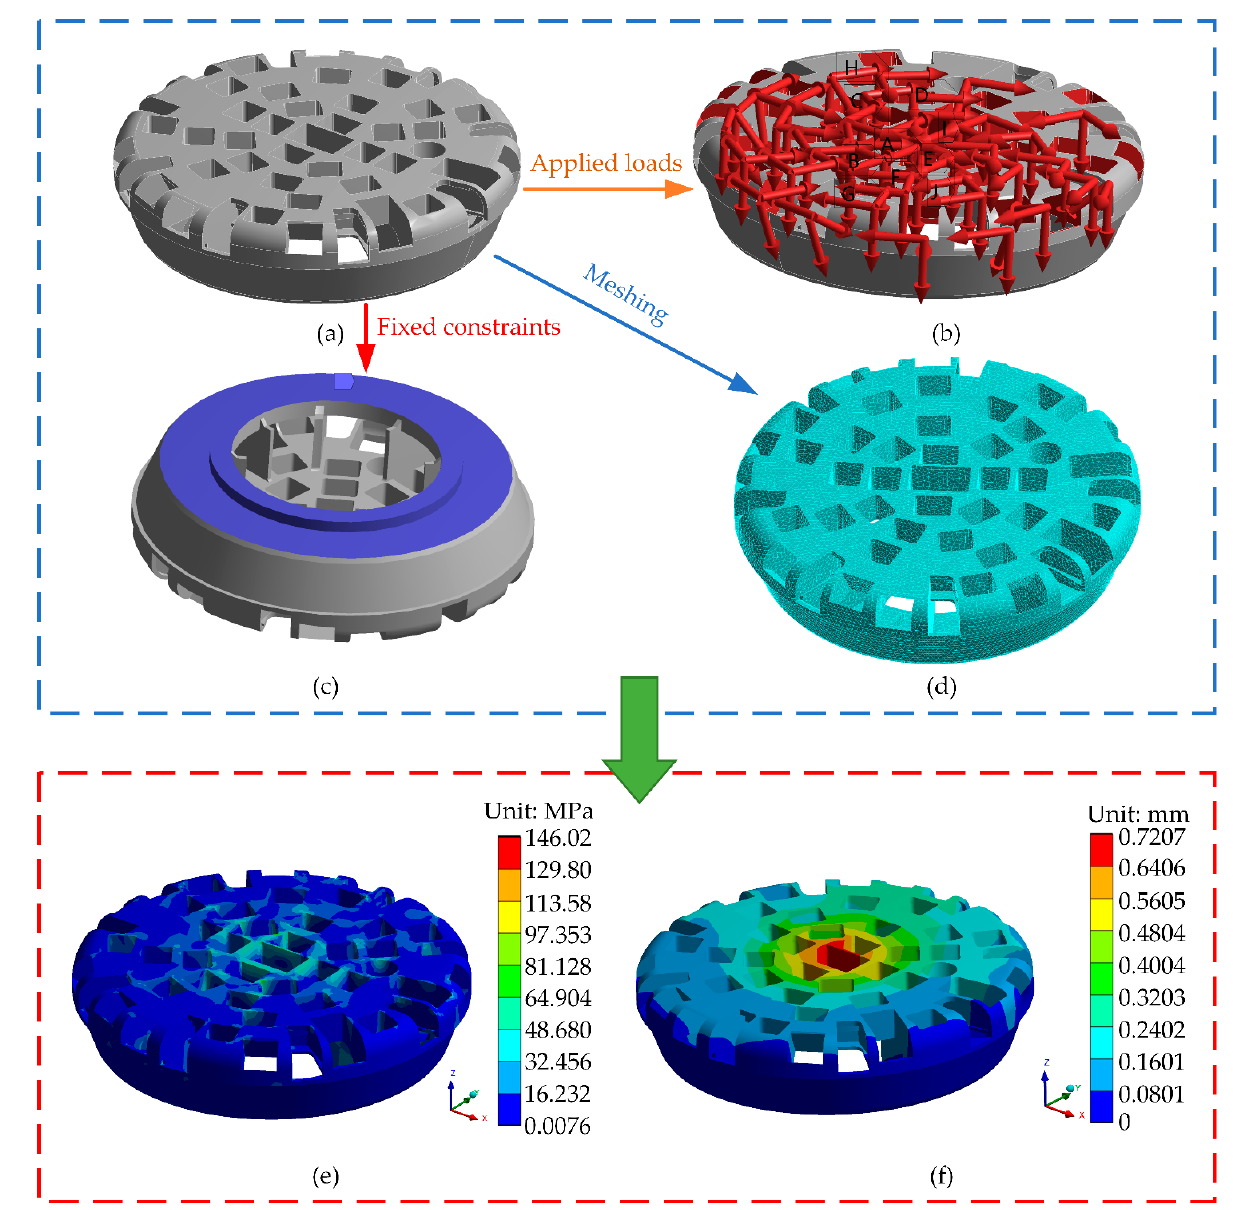
Figure 2. Finite element analysis of a TBM cutterhead: ( a ) three-dimensional models, ( b ) loading mode, ( c ) constraint conditions, ( d ) finite element model, ( e ) stress distribution, and ( f ) deformation distribution.